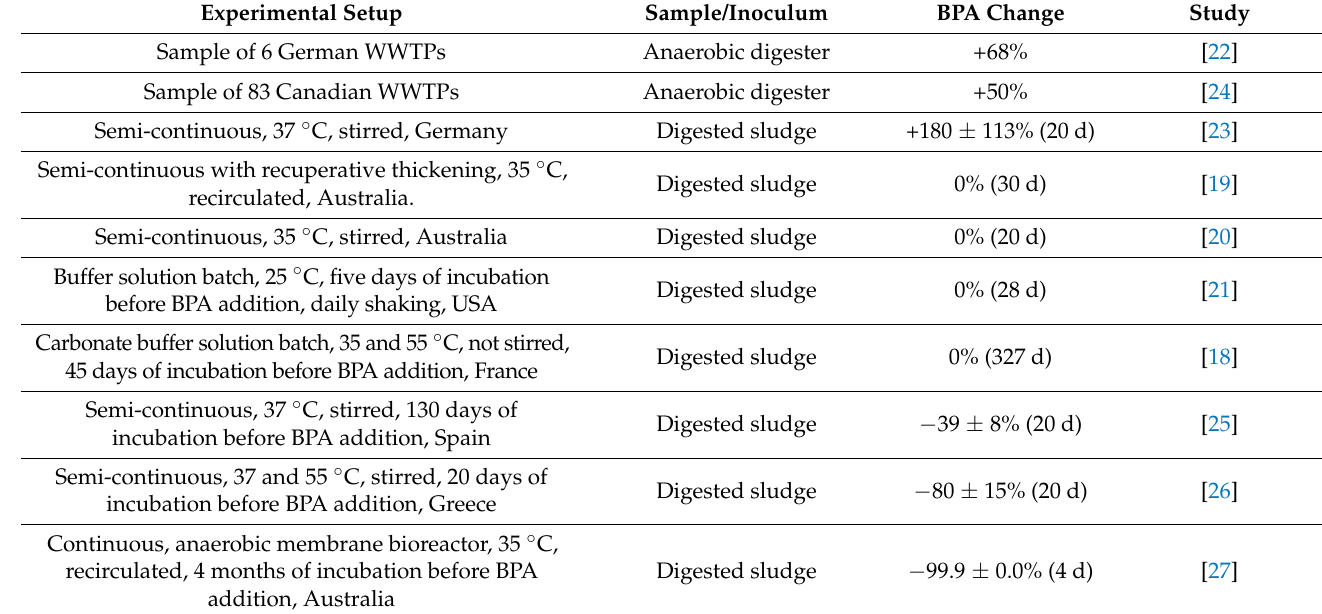
Table 1. Anaerobic removal of bisphenol A (BPA): comparison of BPA changes in other studies. Experimental